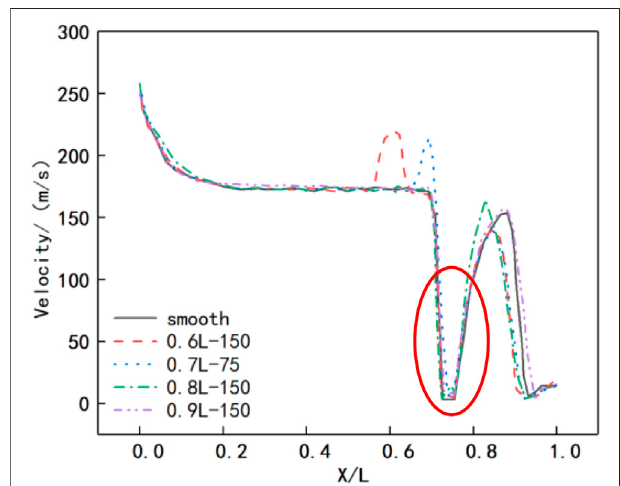
FIGURE 15 | Variation of velocity on the suction side with roughness